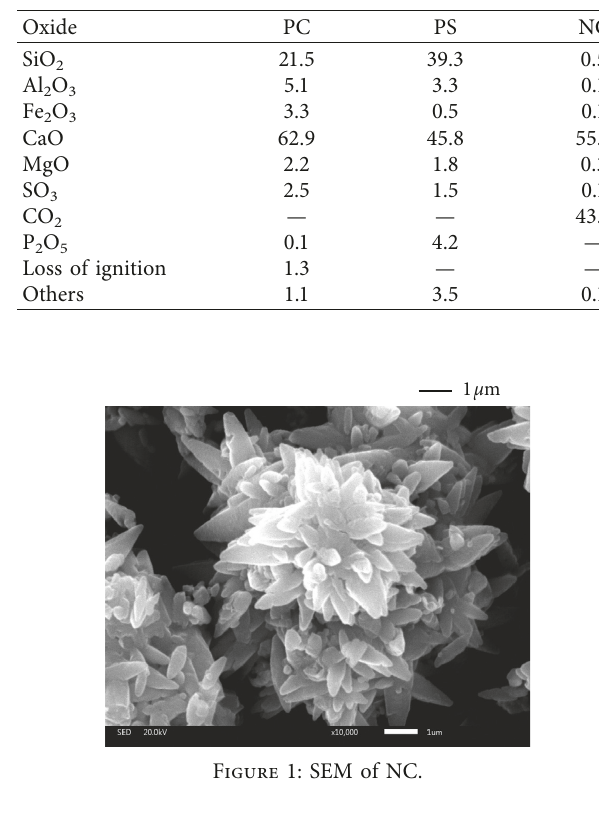
Table 1: Chemical composition of raw materials (%).